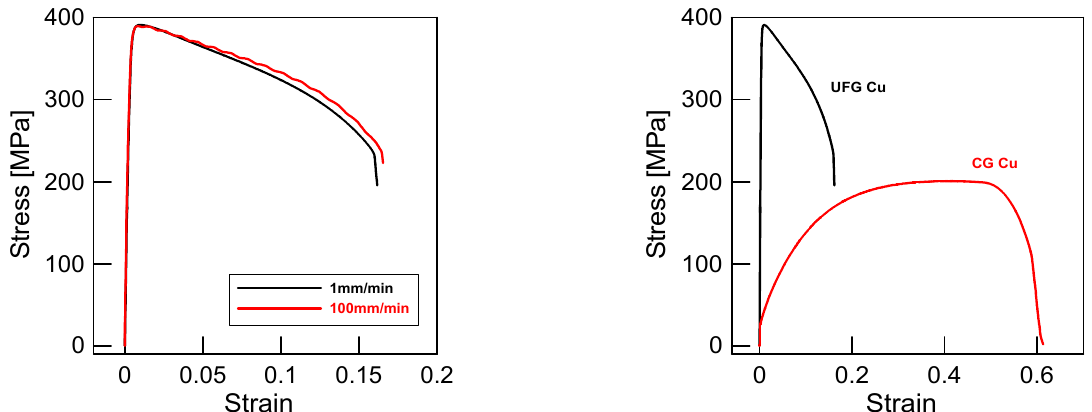
Figure 4: Tensile diagrams of UFG Cu prepared by ECAP, route Bc.